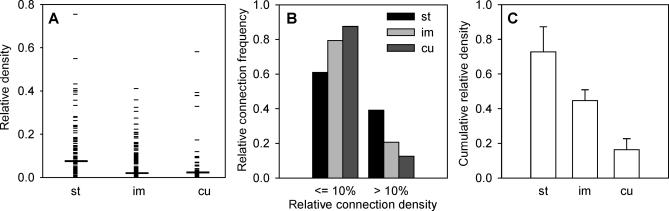
Relationship of Axonal Trajectories to Connections(A) Relative densities of individual projections in the different trajectory classes, straight (st), intermediate (im), and curved (cu). Horizontal lines denote median values. (Spearman's rank correlation of individual projections with trajectory class: ρ = −0.27, p < 0. 00001).(B) Relative distribution of projection trajectories. Relative density of projections (on the x-axis) was calculated as the number of corticocortical projection neurons in each area, divided by the total number of labeled neurons found for all areas in the prefrontal cortex for one injection case. The y-axis indicates the relative frequency of all projections in the given density interval (normalized by all projections in a trajectory class). The diagram demonstrates that weak projections (<10% of relative density) tended to form mostly curved, then intermediate and straight trajectories, whereas greater densities (>10%) resulted predominantly in straight trajectories.(C) Average cumulative density of straight, intermediate, and curved projections originating from individual prefrontal areas. The individual density values also followed the trend displayed here (rank correlation, ρ = −0.50, p < 0.0001).